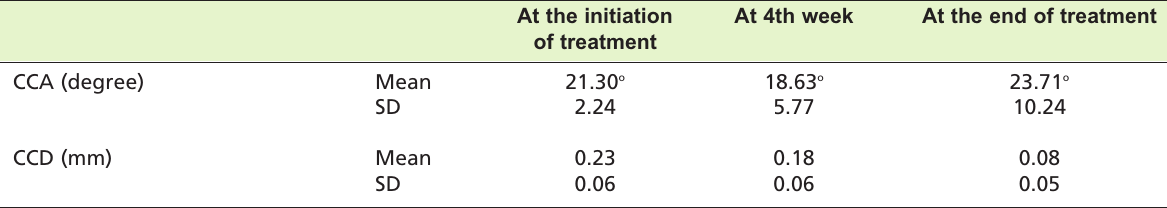
Mean calcaneocuboid angle (CCA) and mean calcenocuboid distance (CCD) values Table III: At the initiation At 4th week